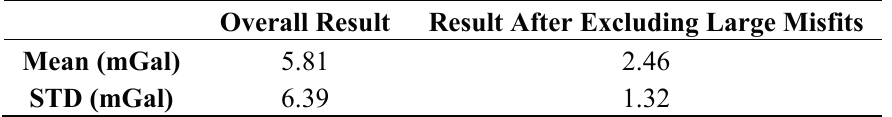
Table 4. Accuracy of estimated gravity disturbances from the proposed